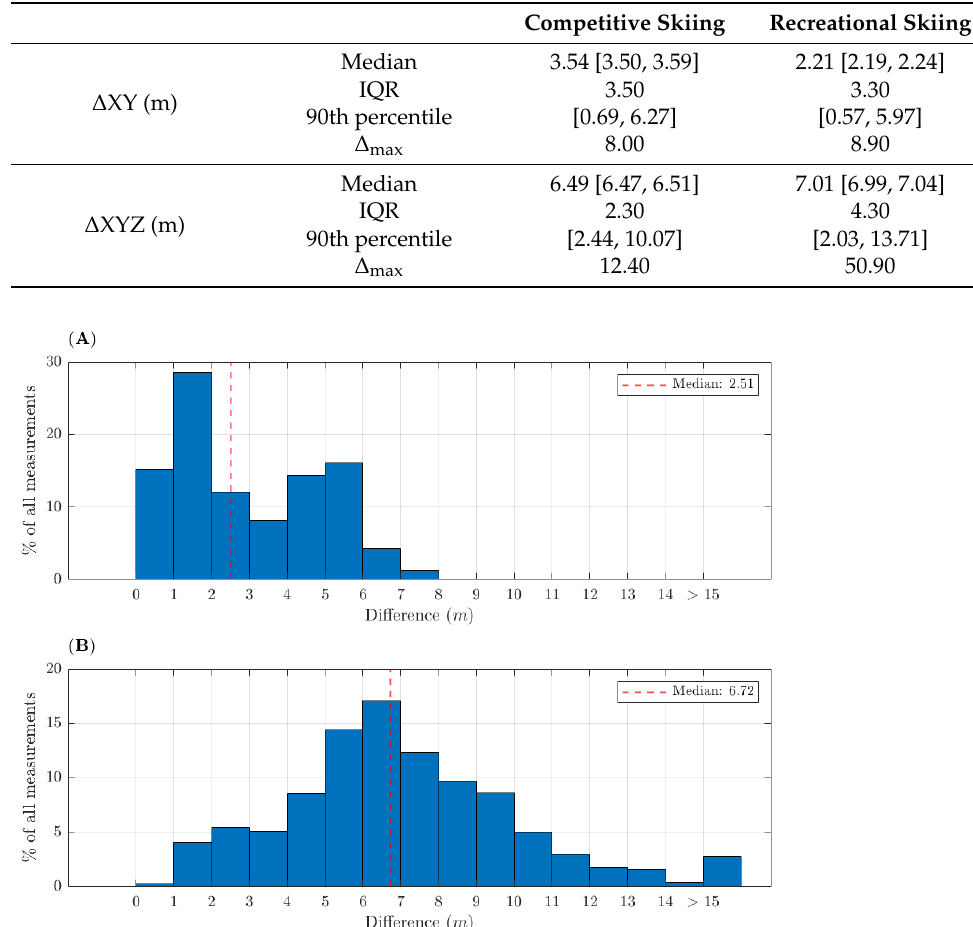
Table 3. Summary of position errors for competitive and recreational skiing data. Errors are reported as median with 95% confidence intervals, interquartile range (IQR) and maximal error ( ∆ max) for position error in the horizontal plane ( ∆ XY) and position error in three dimensions ( ∆ XYZ).